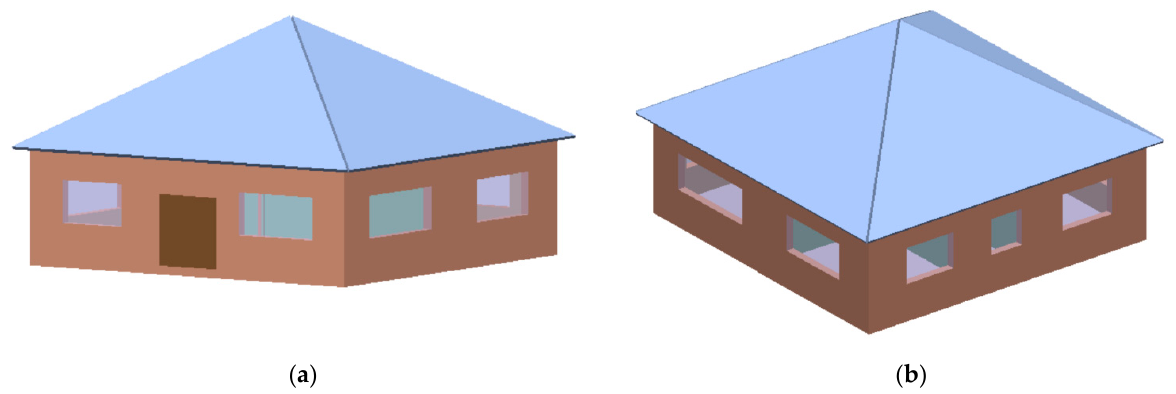
Figure 1. 3D building model: ( a ) south facing façade; ( b ) north and east facades.